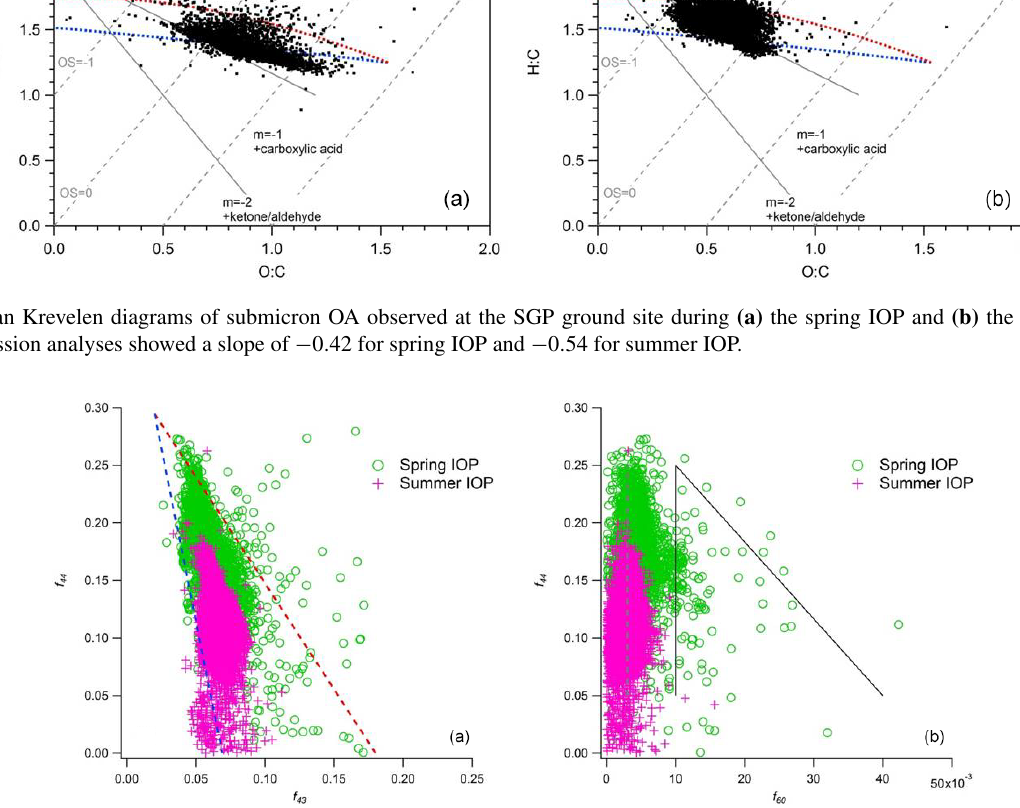
and C 2 H 3 O + ) to the total organic signal, 7